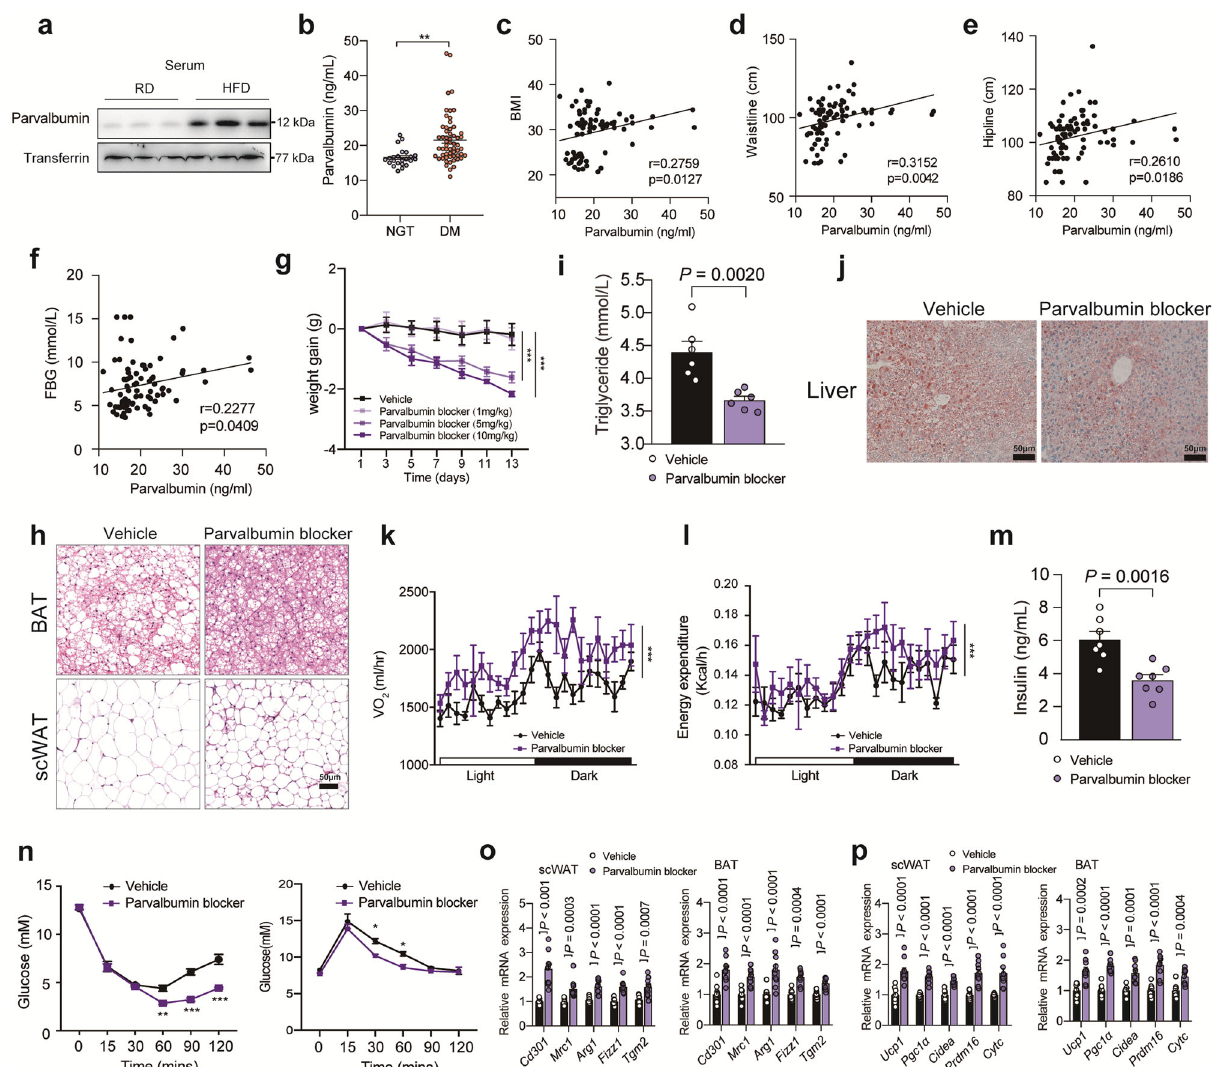
Fig. 7 Parvalbumin blocker ameliorates HFD-induced obesity. a Parvalbumin protein levels in serum from RD- or HFD-fed mice. b Serum parvalbumin levels in lean and obese individuals (lean, n = 23; obese, n = 58). P value: 0.0011. The correlation between BMI ( c ), waistline ( d ), hipline ( e ) and FBG ( f ) with serum parvalbumin. HFD-fed mice were injected daily with vehicle ( n = 14) or parvalbumin blocker (5 mg kg-1, n = 13) for 2 weeks. The weight gain ( g ), representative images of H&E staining of BAT and scWAT ( h ), circulating triglycerides ( i ), representative images of oil O Red staining of liver ( j ), VO 2 ( k ), energy expenditure ( l ), and circulating insulin were determined ( n = 6 per group). scale bar = 50 μ m. n Insulin tolerance test and glucose tolerance test of vehicle or parvalbumin blocker injected mice ( n = 6 per group). P value: 0.0036, <0.0001, <0.0001, 0.0215, 0.0376. Representative thermogenic ( o ) and M2 macrophage marker ( p ) gene expression in scWAT and BAT of vehicle or parvalbumin blocker injected mice ( n = 10 per group). Data are represented as mean ± SEM. P values were determined by unpaired two-tailed Student ’ s t test ( b , o , and p ), two-way ANOVA with Tukey ’ s post hoc tests ( g and n ), ANCOVA using weight as a covariable ( k and l ) or Pearson correlation analysis ( c – f ). * p < 0.05, *** p < 0.001. Source data are provided as a Source Data fi fed mice (Fig. 7a), indicating its correlation with obesity. Remarkably, we found that serum levels of parvalbumin in obese human individuals were signi fi cantly higher than that of non- obese individuals (Fig. 7b). A positive correlation between serum levels of parvalbumin and BMI, waistline, hipline and fasting blood glucose (FBG) was also observed (Fig. 7c – f). Thus, our data indicate that serum level of parvalbumin correlates with both mouse and human obesity.